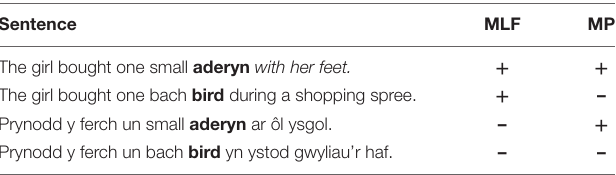
The critical noun is highlighted in bold. An example of a semantically incongruous completion is highlighted in italics, though note that these incongruent completions were dispersed equally between conditions. Italics and bold font are for emphasis and were not used in the experiment.